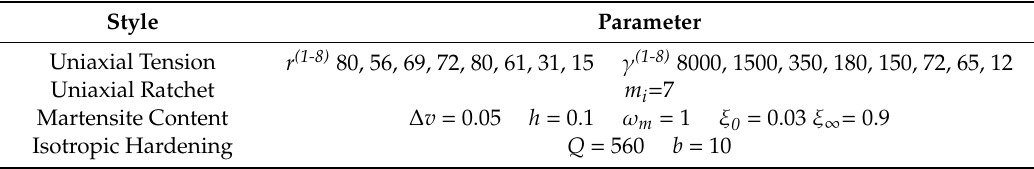
Figure 7. Parameter determination of the constitutive model: (a) isotropic hardening, (b) martensite transformation, (c) determination of parameter ω m. Table 4. Material parameters of the constitutive model.